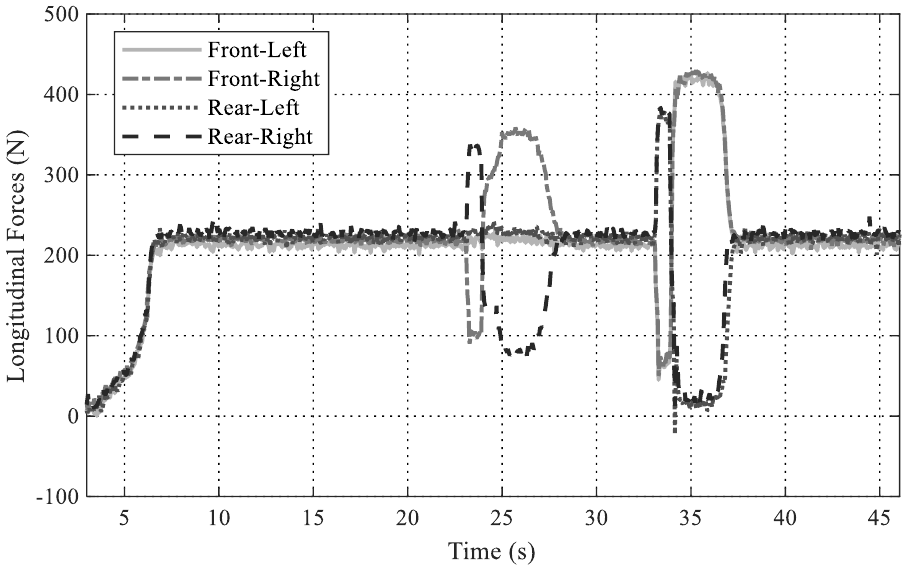
Figure 22. Longitudinal Driving Forces Acted on each